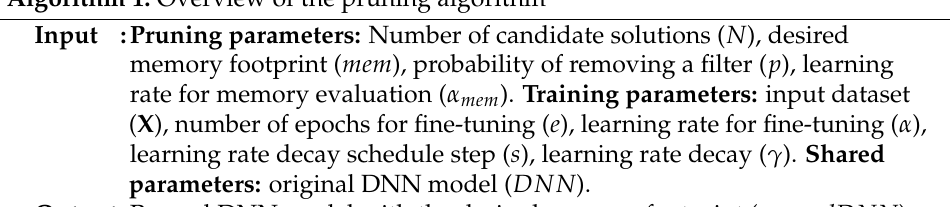
Algorithm 1: Overview of the pruning algorithm